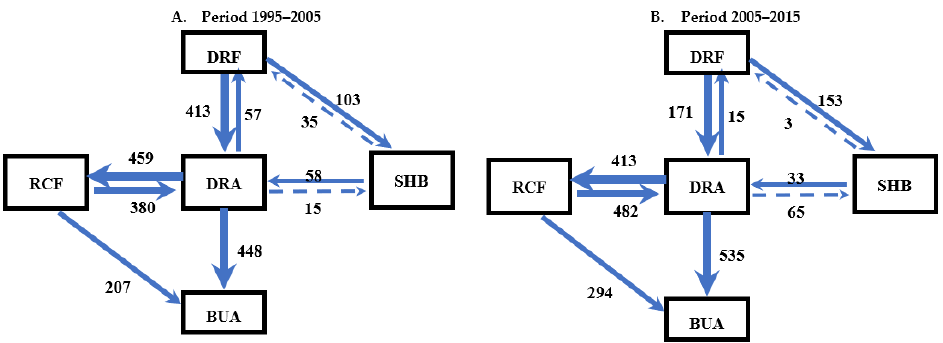
Figure 6. Primary land-use transitions and their magnitude (in km 2 ) for period ( A ) 1995–2005, ( B ) 2005–2015, DRF: dryland forest, DRA: dryland agriculture, SHB: shrubs/bushes, RCF: rice-fields, BUA: built-up areas.